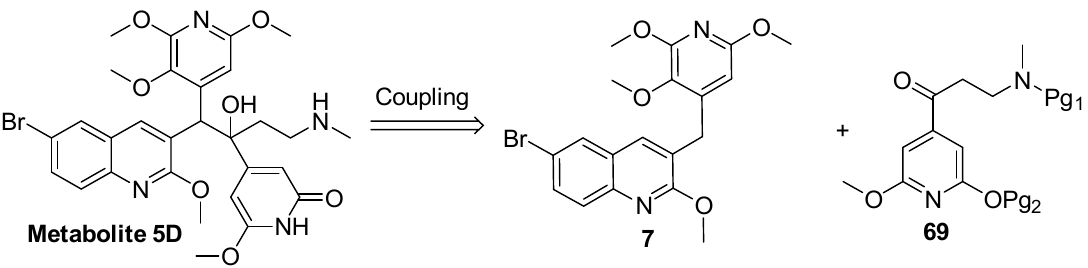
Scheme 17. Proposed synthesis of metabolite 5D